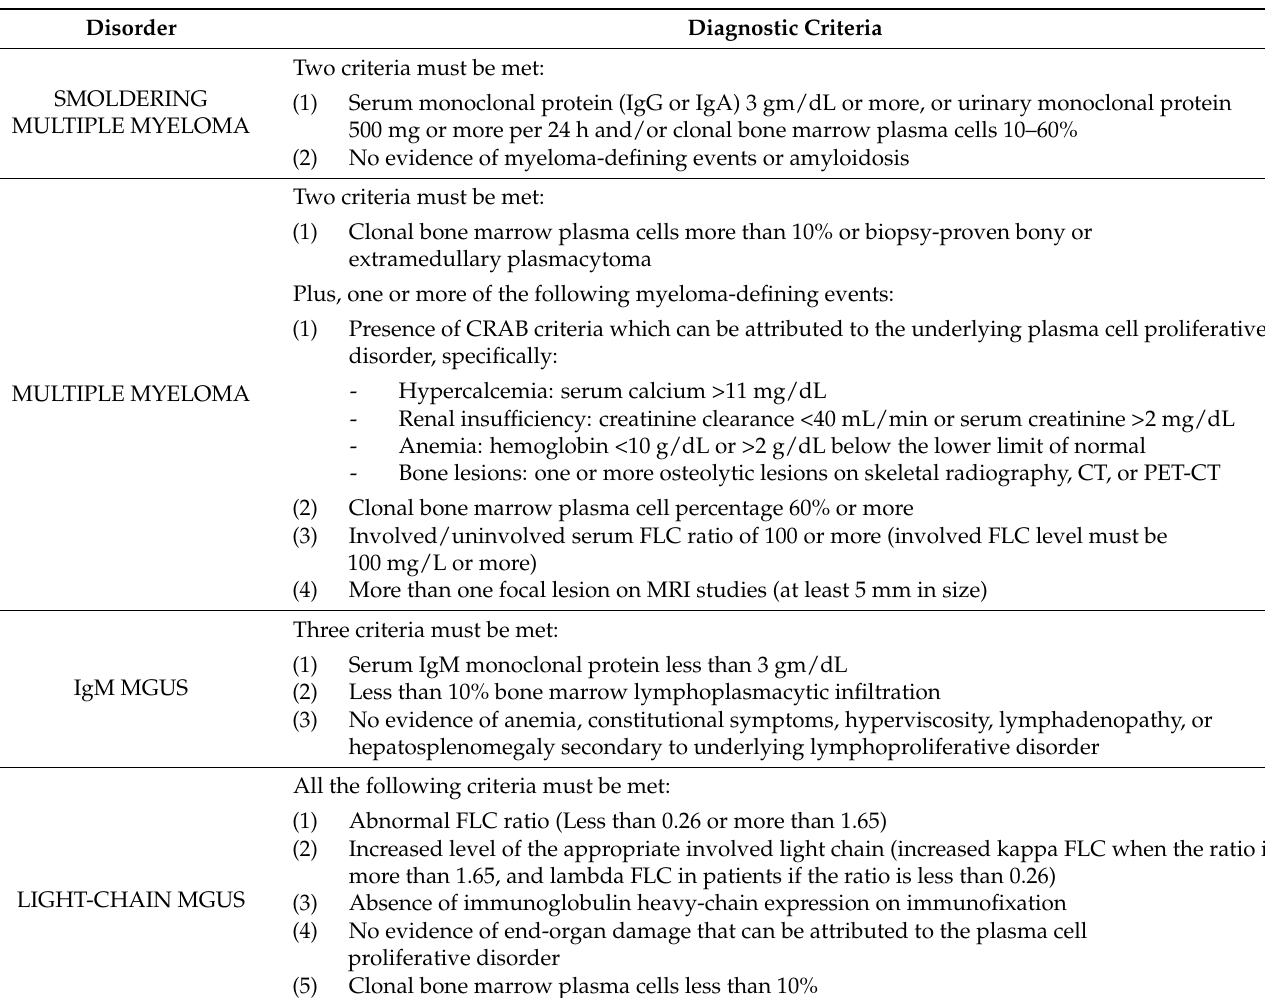
Table 1. The revised diagnostic criteria by the International Myeloma Working Group Diagnostic Criteria for MM and related Plasma Cell disorders [20]. CRAB: Hypercalcemia, Renal failure, Anemia, Bone pain; FLC: free light chains; MGUS: monoclonal gammopathy of undetermined